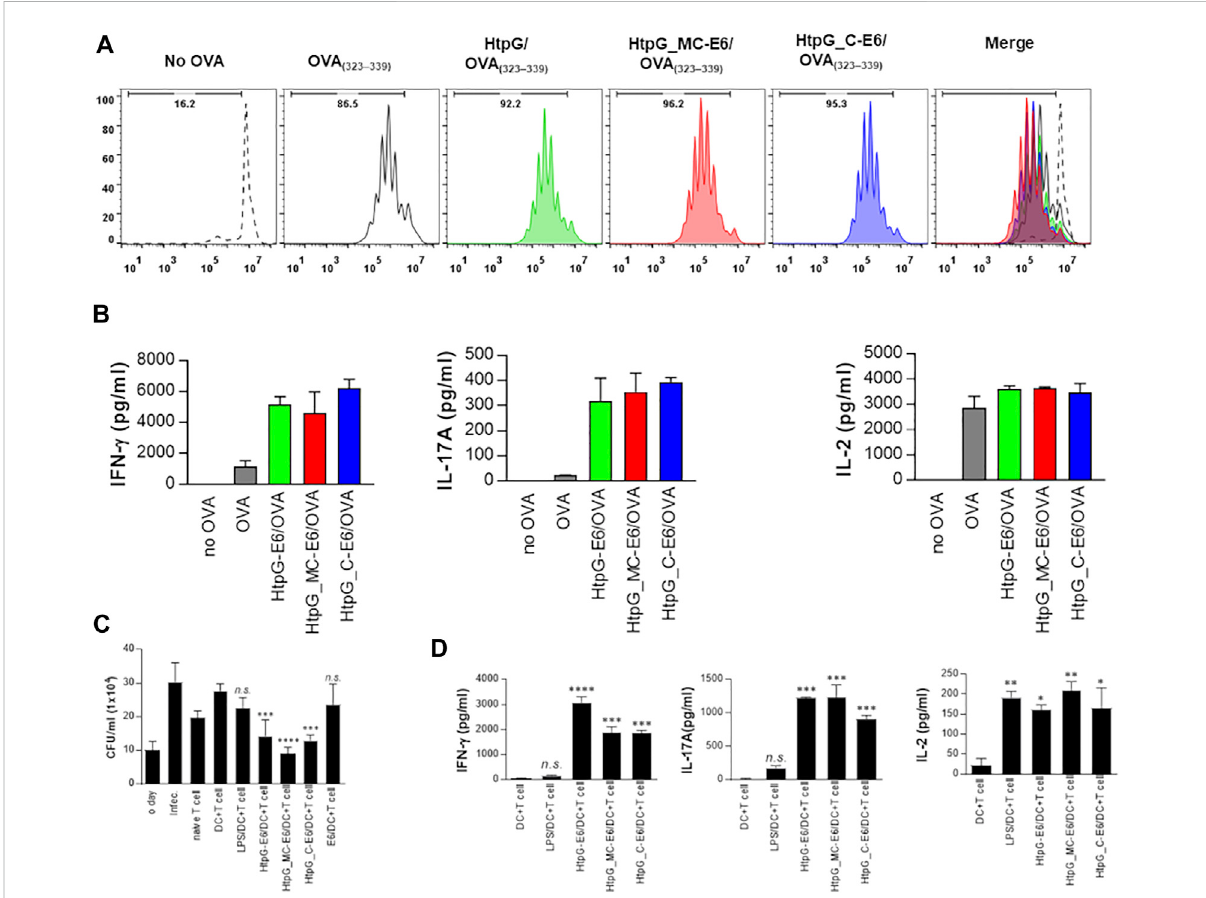
FIGURE 7 ImmunogenicityofthedomainsofHtpG Mtb fusedtoESAT6(E6). (A) ProliferationofOT-II + Tcellsassessedby fl owcytometry:TransgenicOVA- speci fi c CD4 + T cells were isolated, stained with CFSE, and cocultured for 96 h with DCs treated with HtpG Mtb -E6 (2 μ g/ml), HtpG Mtb _MC-E6 (2 μ g/ ml),orHtpG Mtb _C-E6(2 μ g/ml),thenpulsedwithOVA 323 – 339 (1 μ g/ml)forOVA-speci fi cCD4 + Tcells,respectively.TcellsonlyandTcellscocultured with untreated DCs served as controls. (B) IFN- γ , IL-2, and IL-17 levels in the culture supernatants harvested after 24 h and assayed by ELISA. (C,D) NaïveTcellsorTcellsactivatedbyunstimulatedDCs,LPS-,HtpG Mtb -E6-,HtpG Mtb _MC-E6-,orHtpG Mtb _C-E6-stimulated DCs(DC:Tcellratio of 1:10 for 3 days) were cocultured with BMDMs infected with Mtb. Intracellular Mtb growth in BMDMs (C) was determined at time points 0 (day 0) and3 daysaftercoculturingwithTcellsorwithoutTcells(control).ThecytokinelevelsinculturesupernatantsweremeasuredbyELISA (D) .Thedata shown are the mean values ± SD ( n = 3); * p < 0.05, ** p < 0.01, *** p < 0.001, or **** p < 0.0001 for antigen-treated DC cocultured with T cells, compared to untreated DC cocultured with T cell. n. s .: no signi fi cant